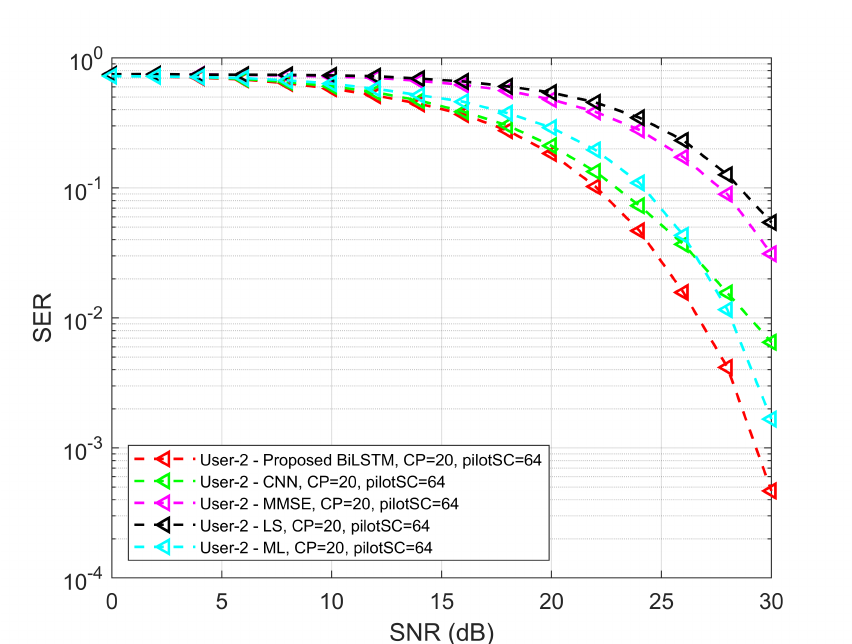
Figure 12. SER versus SNR performance comparison for UE 2 of the proposed method against CNN, LS, MMSE, and ML.